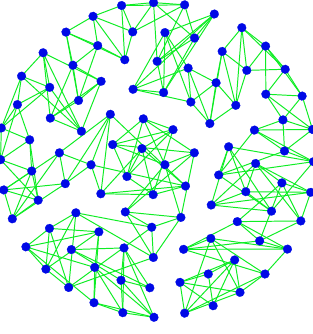
Figure 4. The subnet G 1 of G